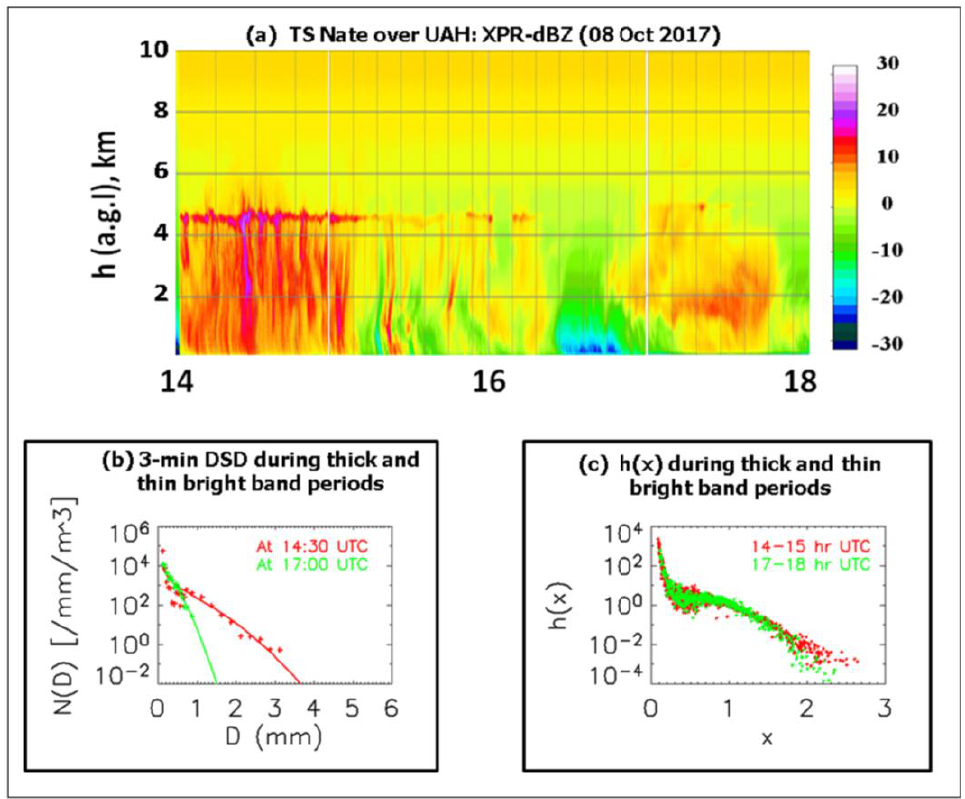
Figure 3. ( a ) Vertically pointing X-band Doppler radar (XPR) observations during tropical storm Nate at UAH during stratiform rain period with varying bright-band thickness; ( b ) three-minute composite DSDs from the MPS-2DVD measurements corresponding to thick bright-band period (14:30 UTC) in red and weak bright-band period (17:00 UTC) in green, together with their fitted GG curves; ( c ) h ( x ) versus x computed from three-minute DSDs during 1400–1500 UTC (thick bright band period) in red, and during 1700–1800 UTC (weak bright band) in green, which show considerable overlap.